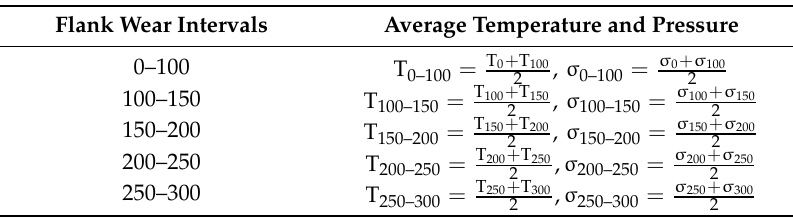
Table 2. Procedure to calculate the average process variables.